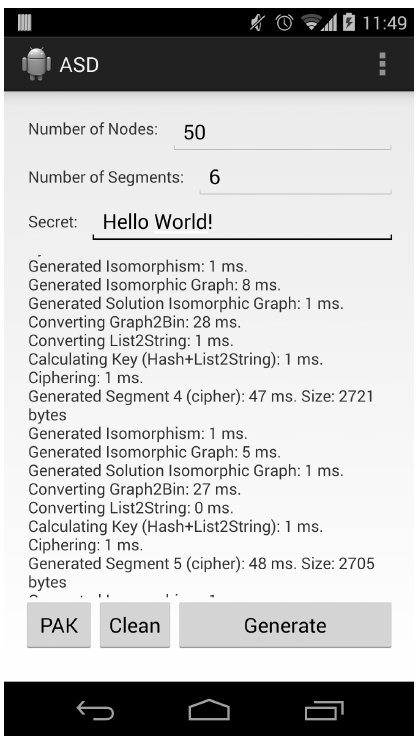
Figure 4. Android application